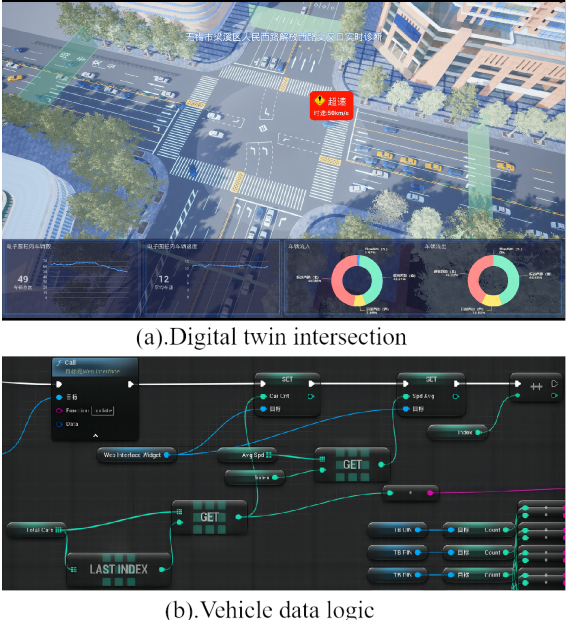
Figure 12. Digital twin intersection. ( a ) The overall display of digital twin intersection. ( b ) Vehicle data display